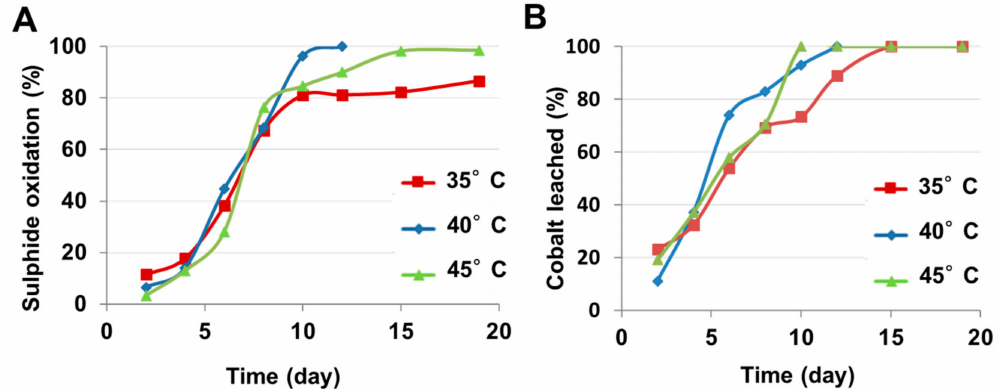
Figure 4. Calculated percentage of ( A ) sulphide oxidation and ( B ) cobalt in leachate for temperature- modified experiments.